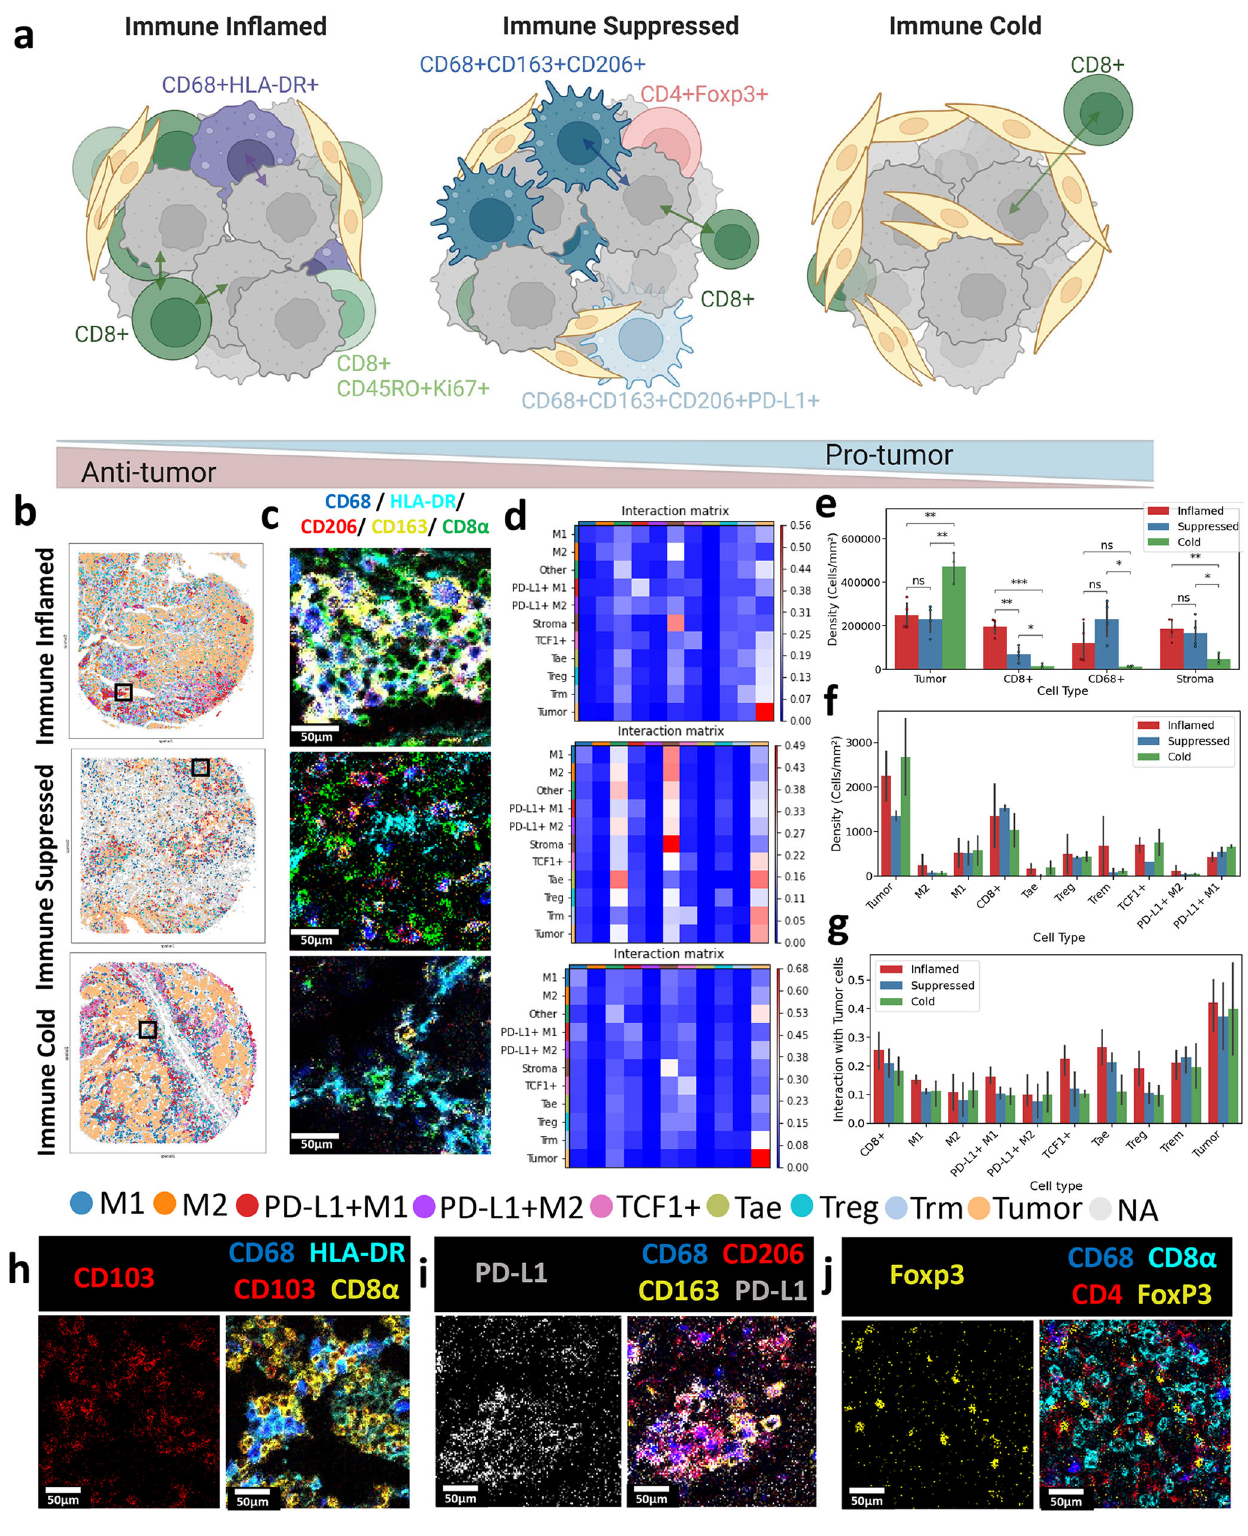
segmented cell region, the mean intensity of each marker expression was calculated. The resulting feature matrix consisted of n rows of the total number of cells ( n = 264,191) and p columns of marker expression. Each column of the feature matrix was z -